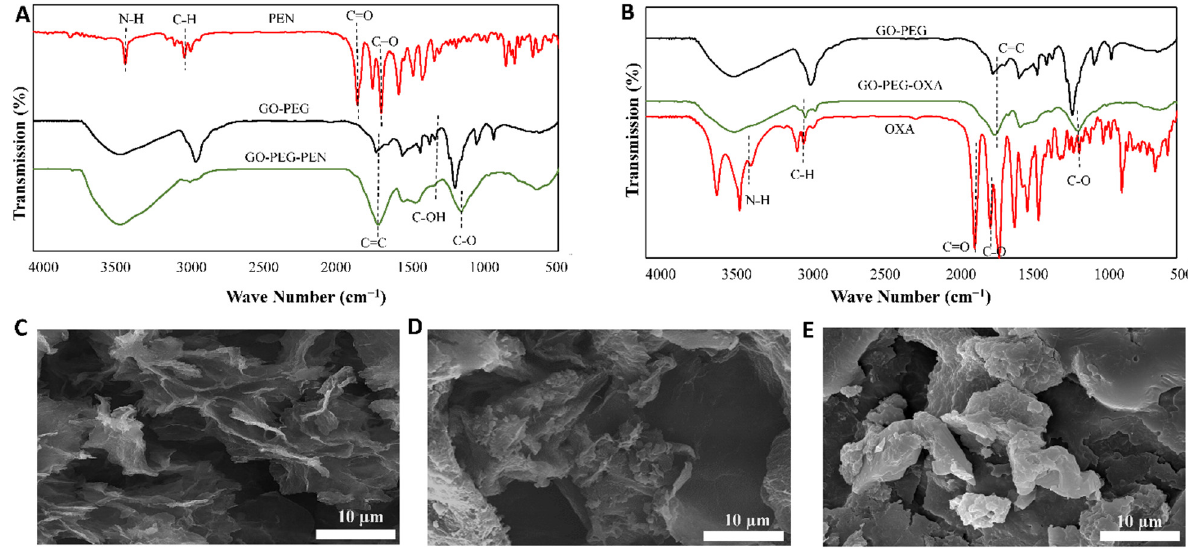
Figure 3. FT-IR spectra of ( A ) GO-PEG-PEN (Penicillin (red), GO-PEG (black), and GO-PEG-penicillin (green)); ( B ) GO-PEG-OXA (Oxacillin (red), GO-PEG (black), and GO-PEG-oxacillin (green)); and the FE-SEM images of ( C ) GO-PEG without antibiotic; ( D ) GO-PEG-PEN, and ( E ) GO-PEG-OXA.